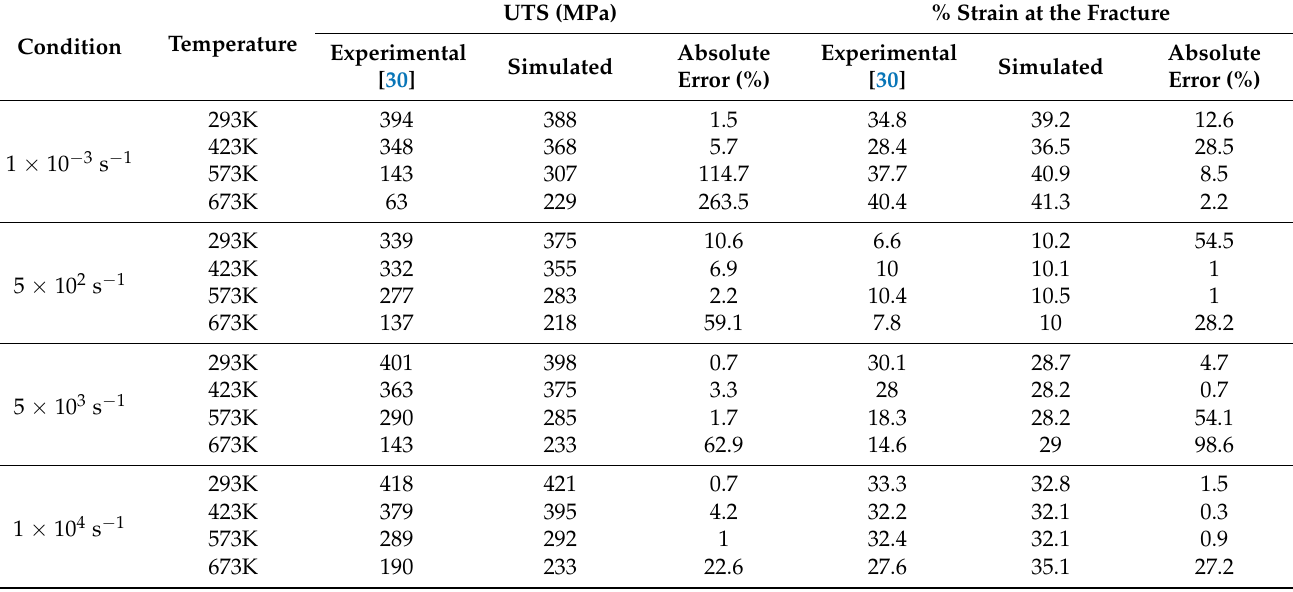
Table 3. Simulated and experimental tensile properties at different temperature and